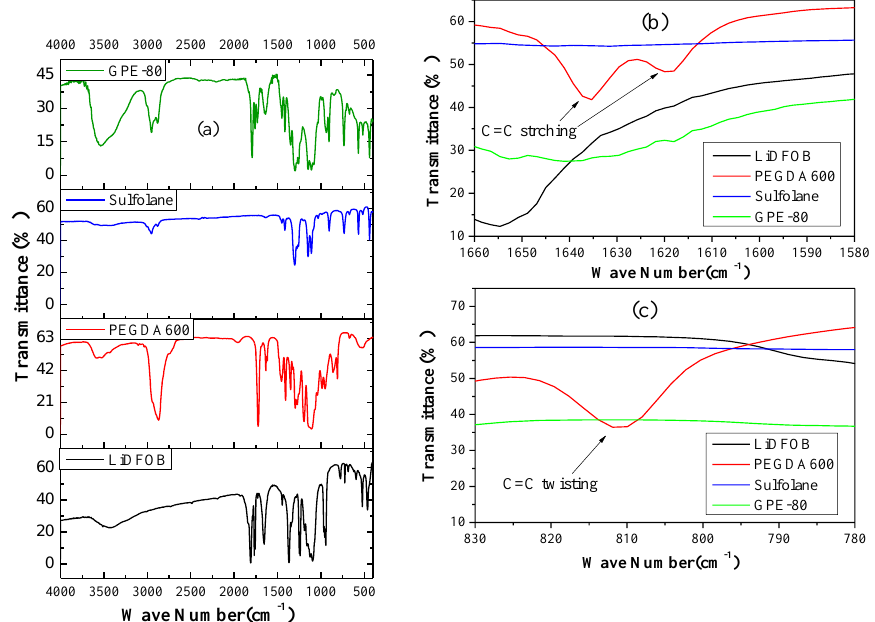
Figure 2. ( a ) FTIR results of raw materials and GPE-80, ( b ) Enlargement of 1660—1580 cm −1 . ( c ) Amplification of 830—780 cm −1 .